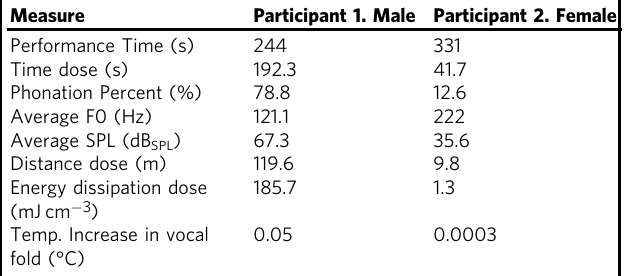
Table 1 Summary statistics of voice dosimetry parameters of two